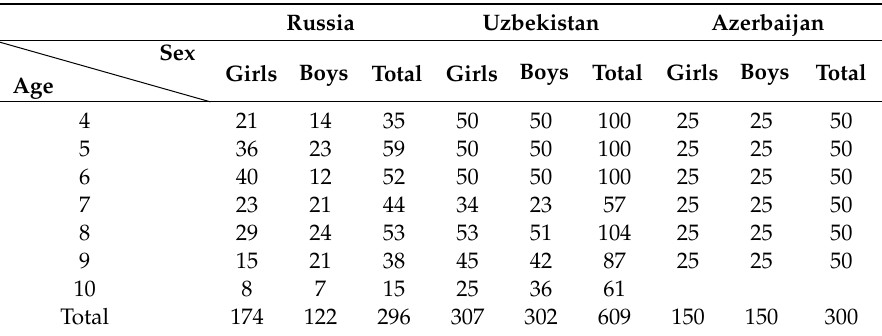
Table 2. Sample distributions by age and